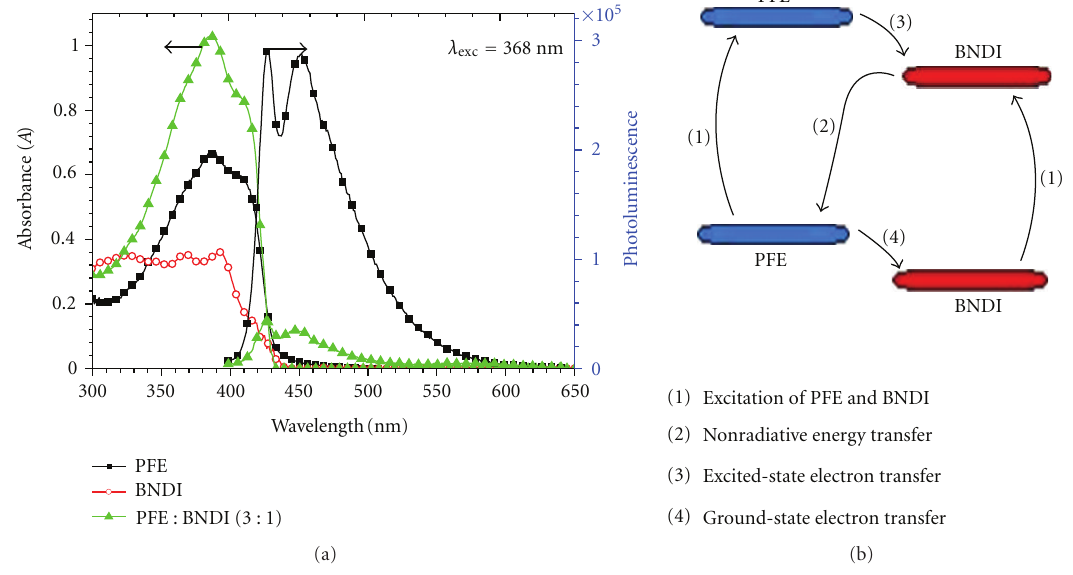
Figure 3: Absorption and photoluminescence spectra of (a) neat PFE and PFE:BNDI (3:1) and absorption spectrum of BNDI films and (b) proposed mechanism for the relationship between PFE and